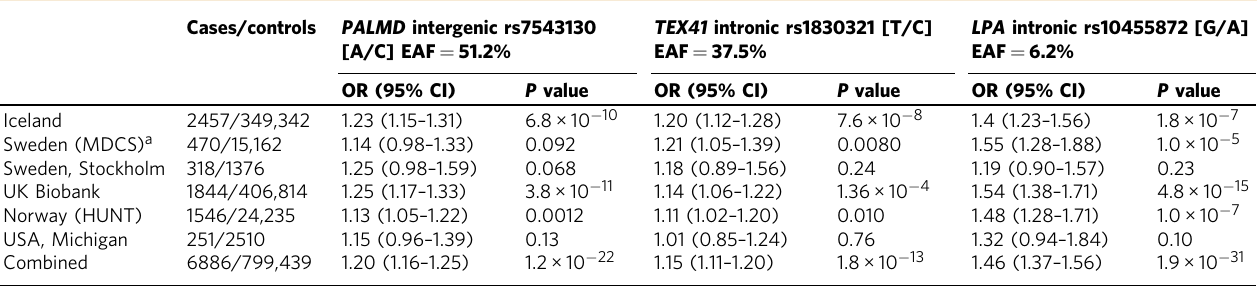
Table 1 Meta-analysis results for aortic valve stenosis variants